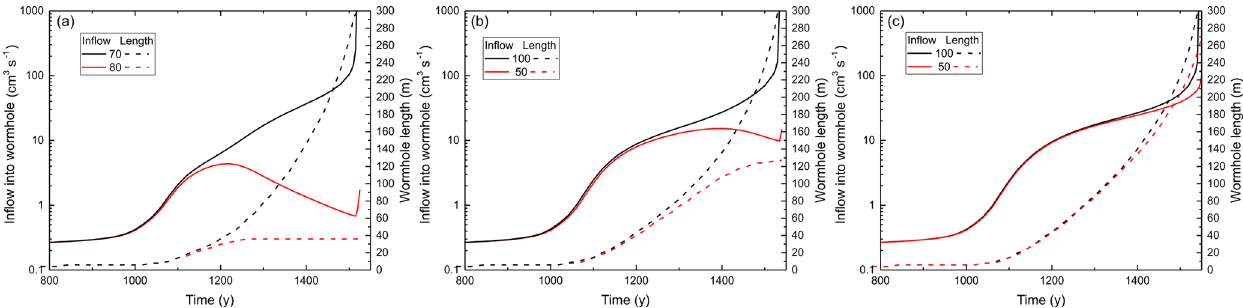
Figure 14. Temporal evolution of flow (full lines) and length (dashed lines) of the interacting wormholes of Fig. 12. Labels corresponds to Fig. 12.